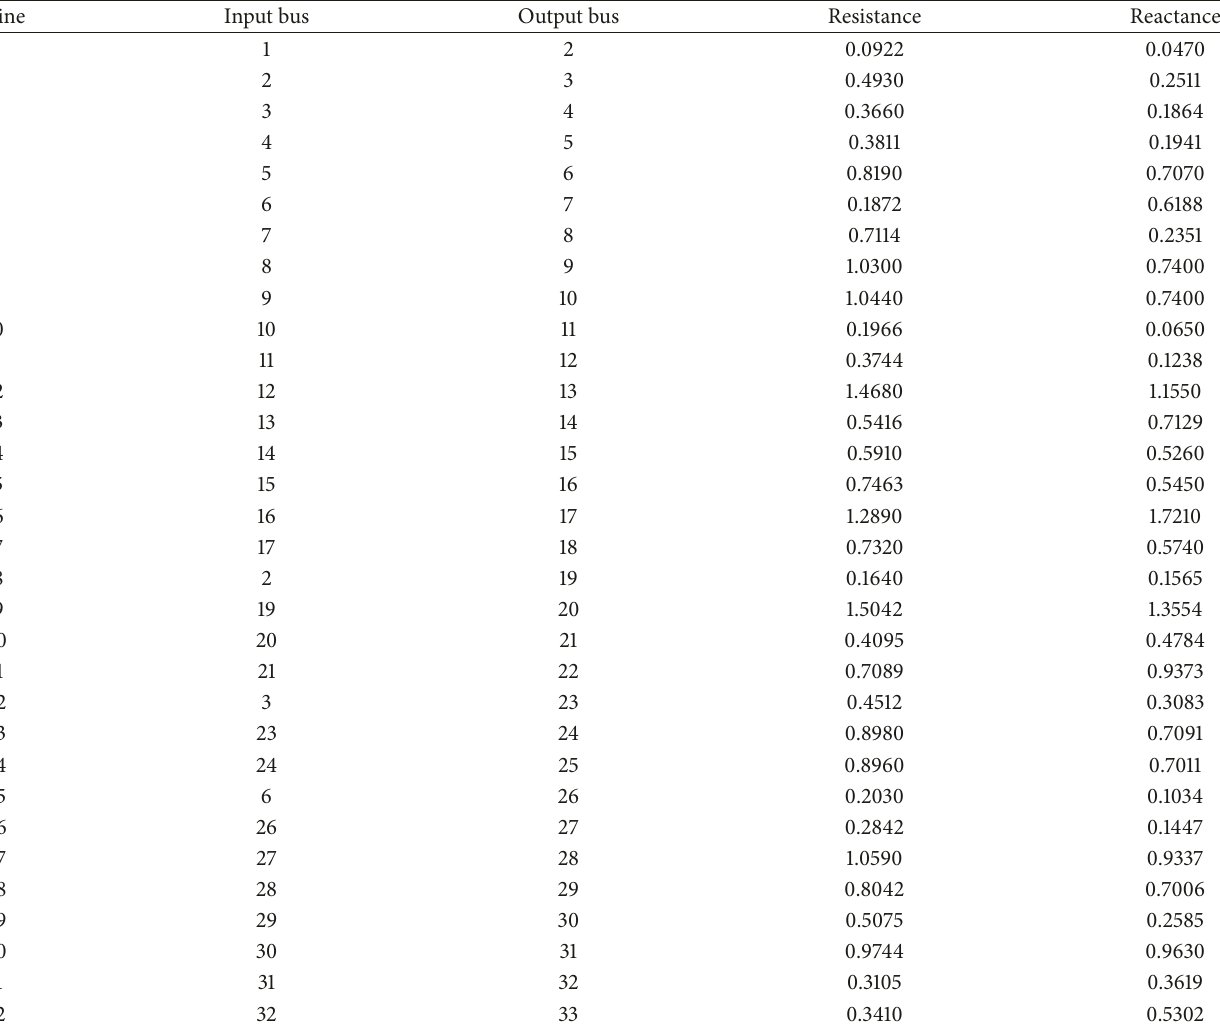
Table 1: Network